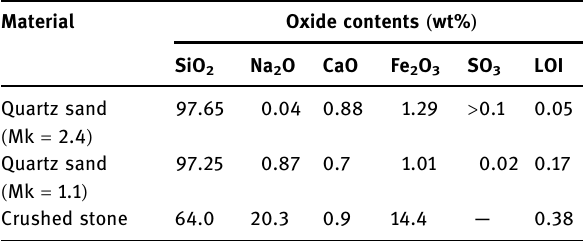
Table 6: Chemical composition of aggregates Material